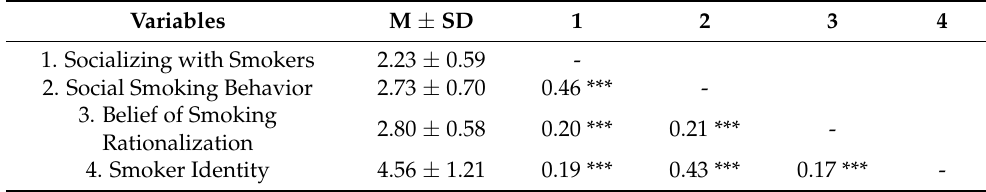
Table 1. Mean scores, standard deviations, and Pearson’s correlations of the study variables.